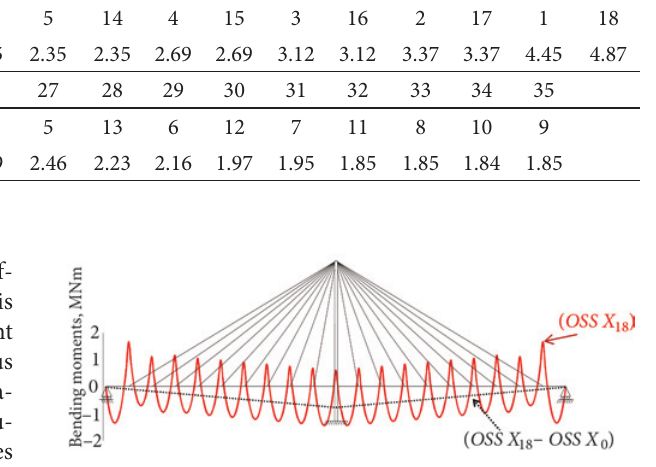
table 3. Tensioning operations of the bridge in WuXi Stage